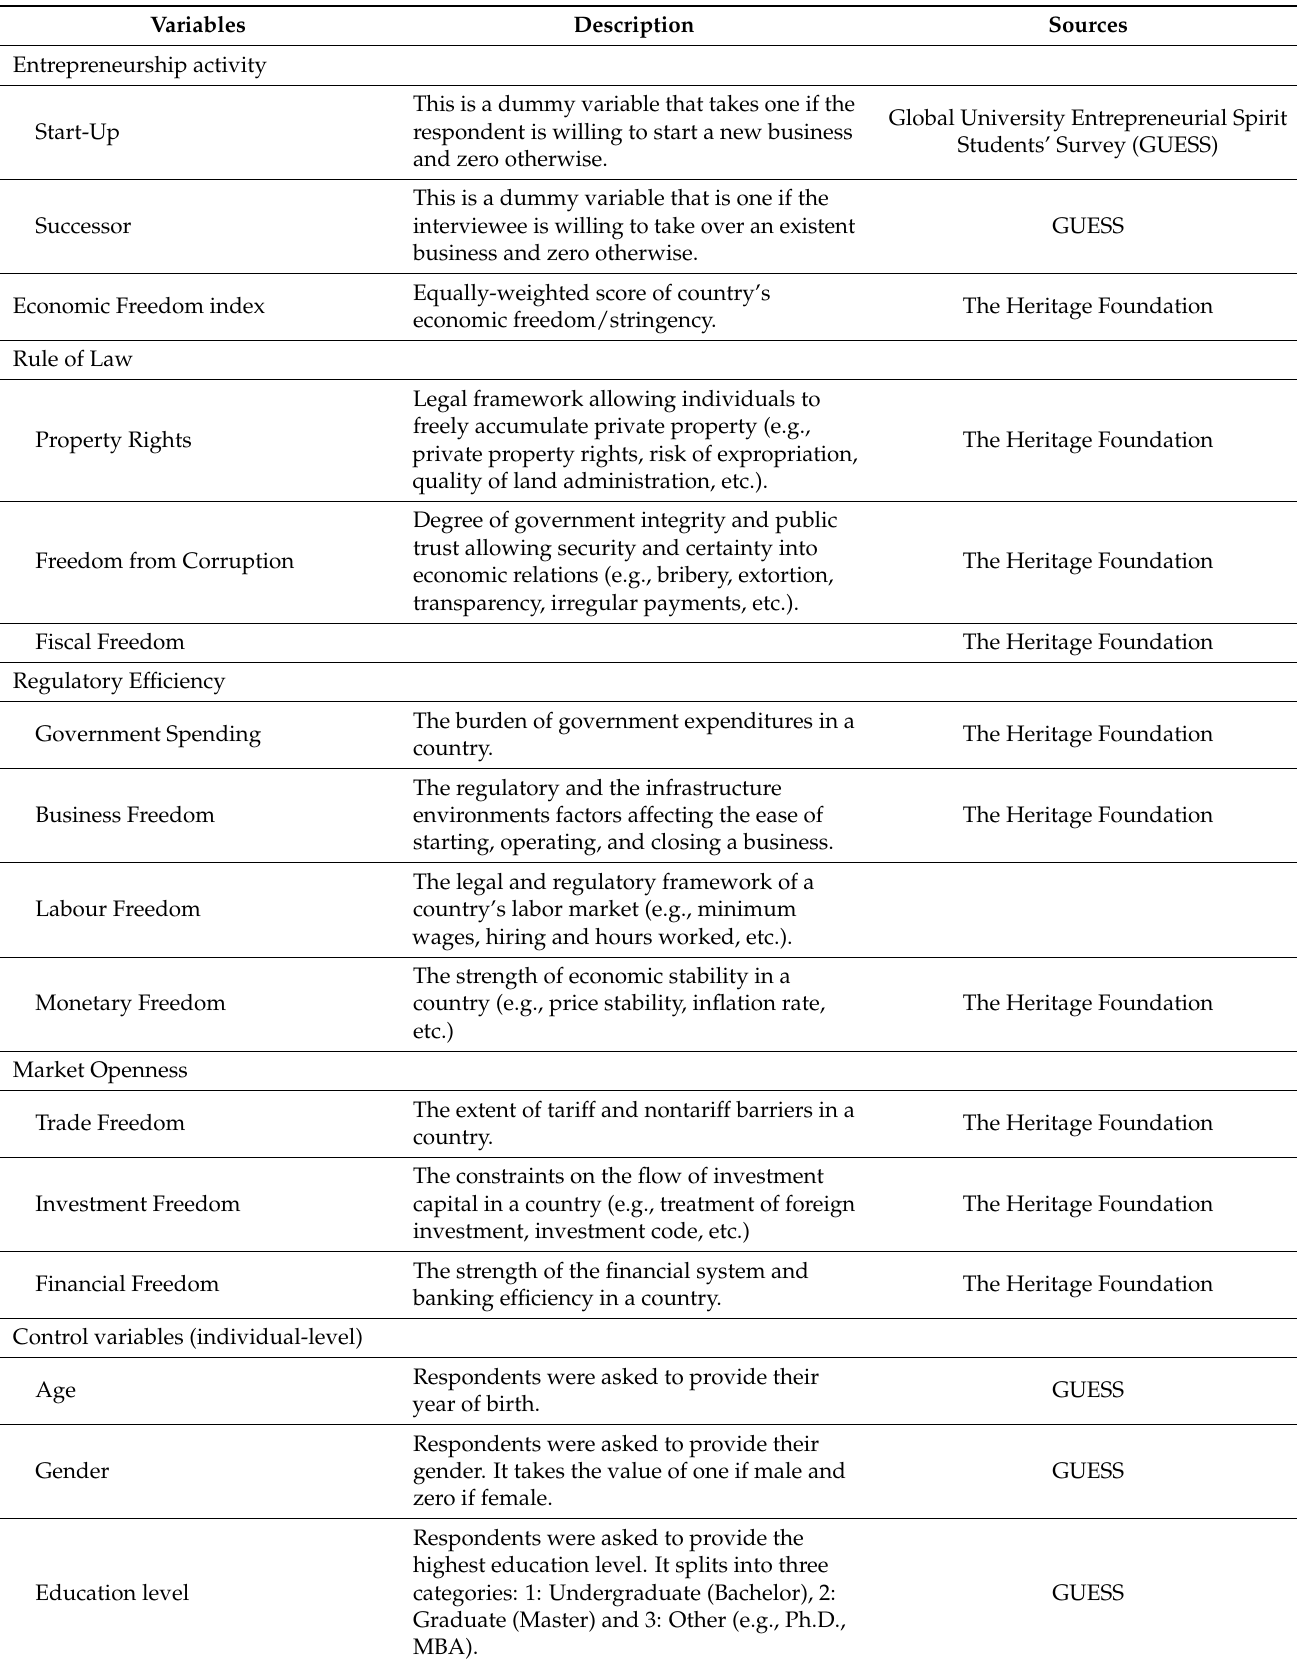
Table 1. Description of the